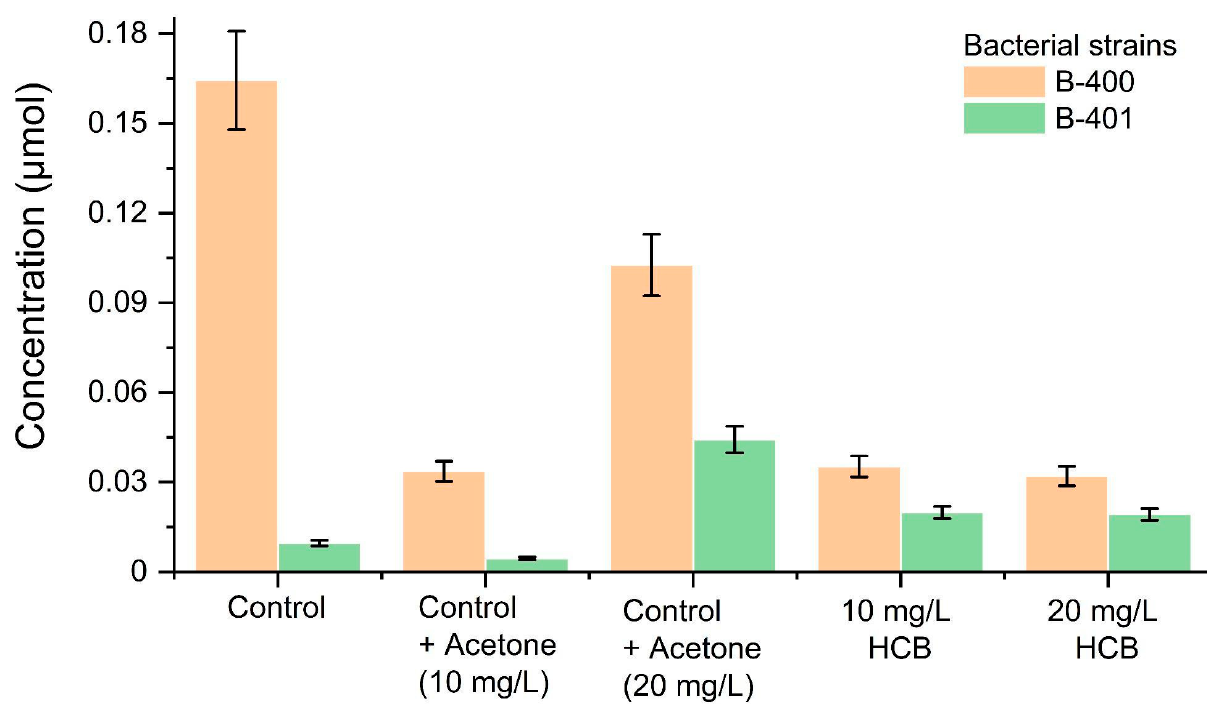
Figure 2. Malondialdehyde (MDA) in the cells of the bacterial strain B-400 and strain B-401.